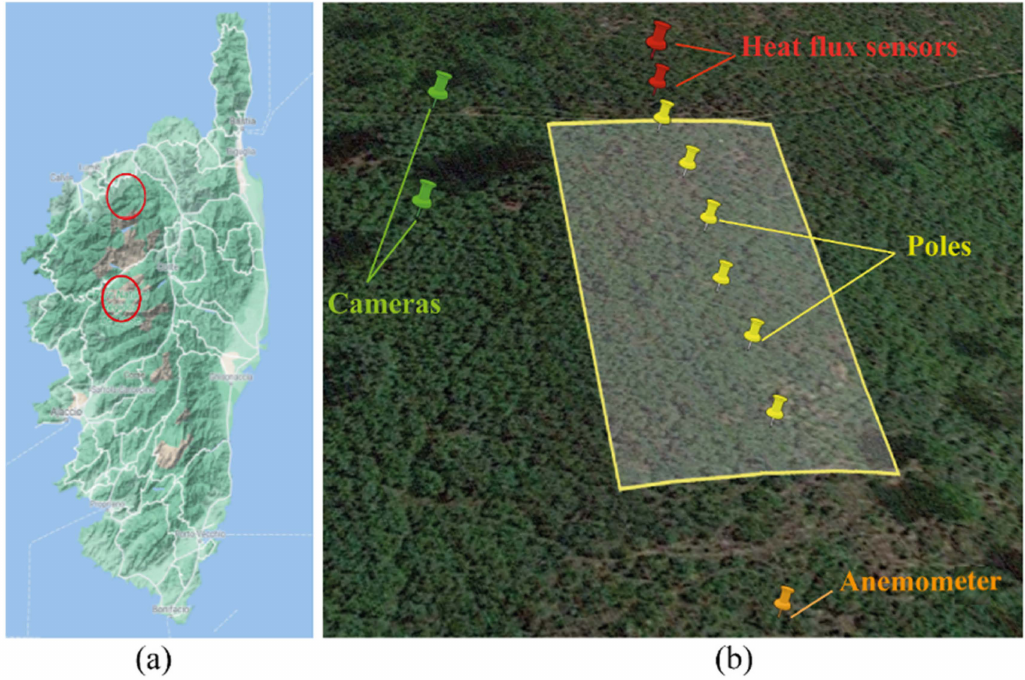
Figure 1. Experimental fire sites in Corsica island: ( a ) locations on the map (red circles); ( b ) view by Google earth and main GNSS measurement points during October 2021